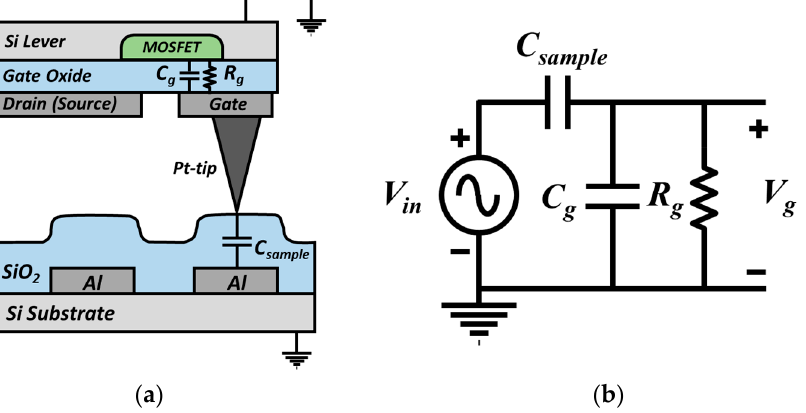
Figure 10. The R-C filter formed between the tip and sample: ( a ) Schematic diagram of the tip-sample structure; ( b ) equivalent circuit model for the structure.